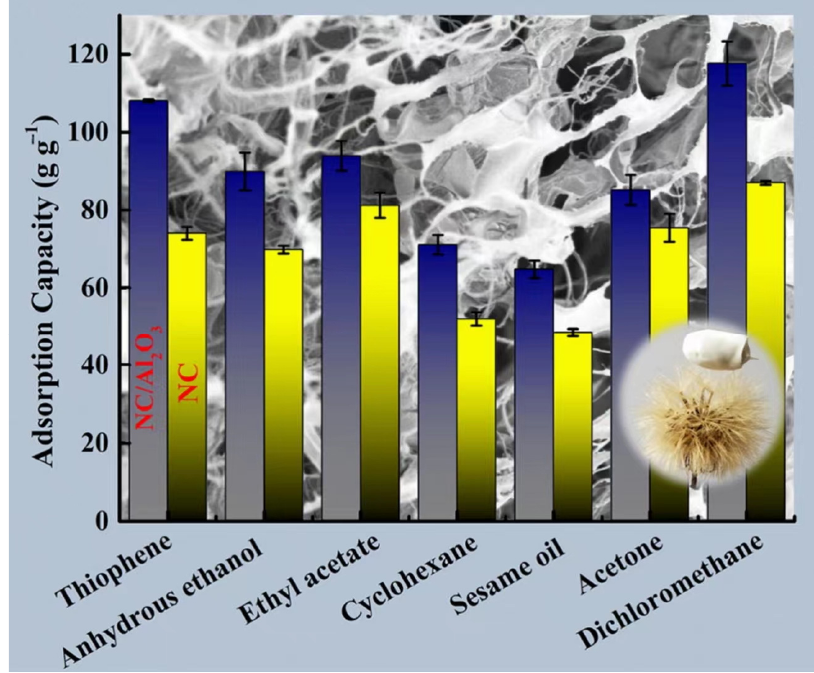
Figure 10. Adsorption capacity of NC/Al 2 O 3 aerogel [159]